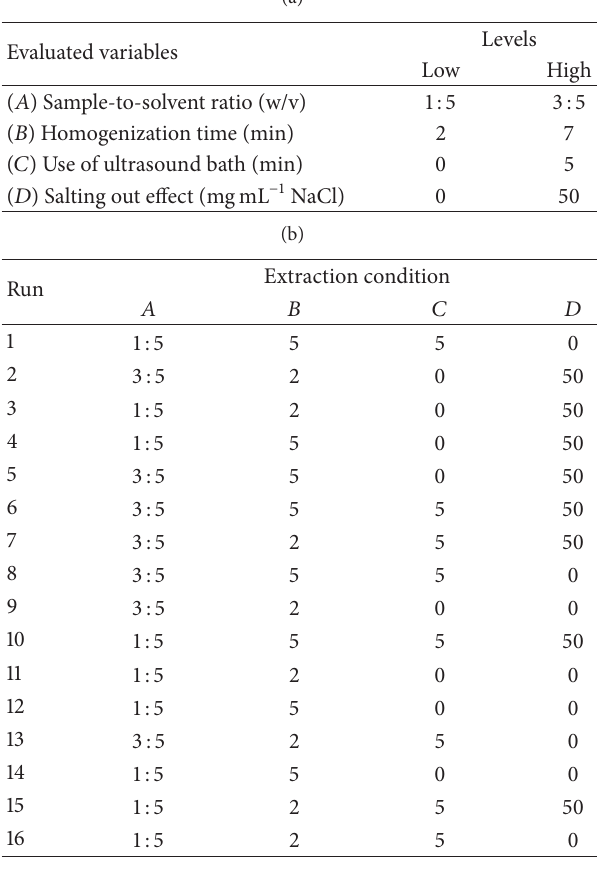
Table 2: Analytical responses values obtained for ITCs concen- tration for the Central Composite Design arrangement. Analyti- cal responses and predicted values for isothiocyanate production (nmolg −1 w.w.).